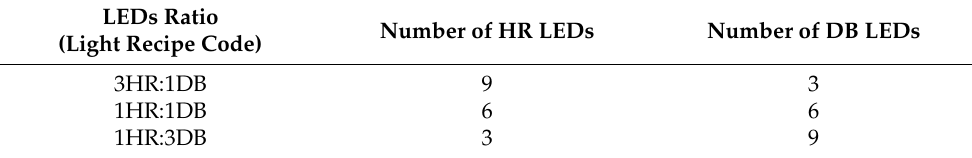
Table 2. Hyper red–deep blue light-emitting diodes (LEDs) ratio for the considered light recipes.